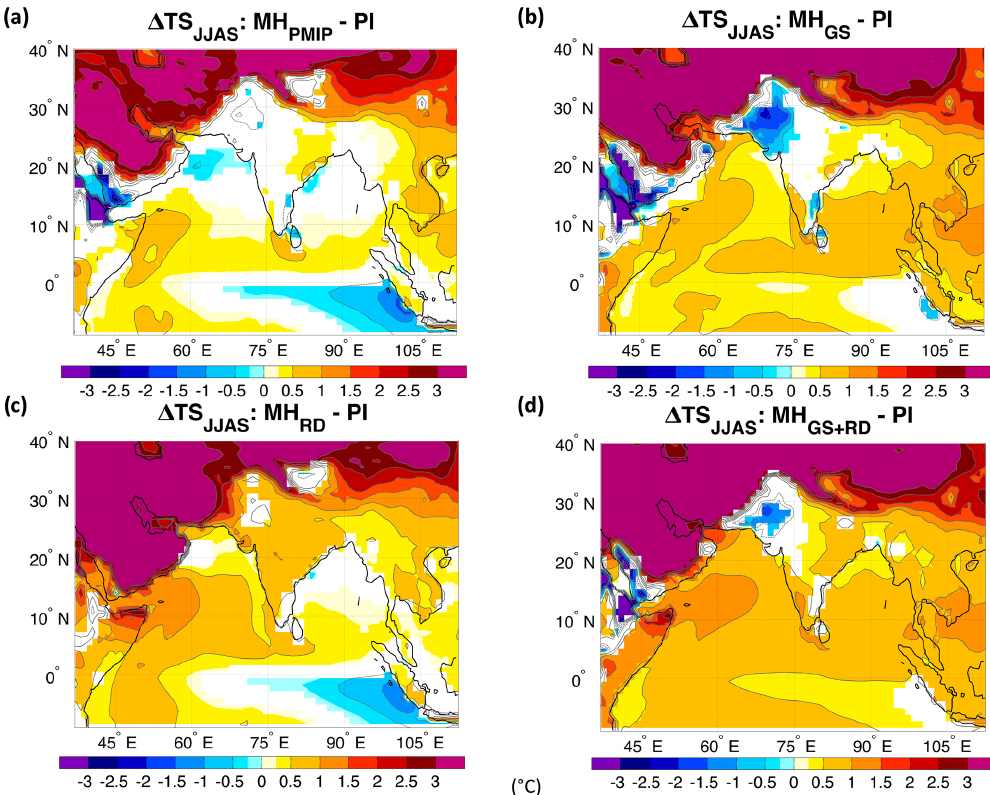
Figure 4. Changes in summer (JJAS) surface temperature (TS; ◦ C) for the (a) mid-Holocene-only orbital forcing (MH PMIP ); (b) the Sahara greening (MH GS ); (c) the dust-only reduction (MH RD ); and (d) the Sahara greening and dust reduction (MH GS + RD ) experiments relative to the PI reference simulation. The contour lines follow the color-bar scale (the 0 lines are omitted for clarity). Only differences significant at the 95% confidence level using the Student t test are